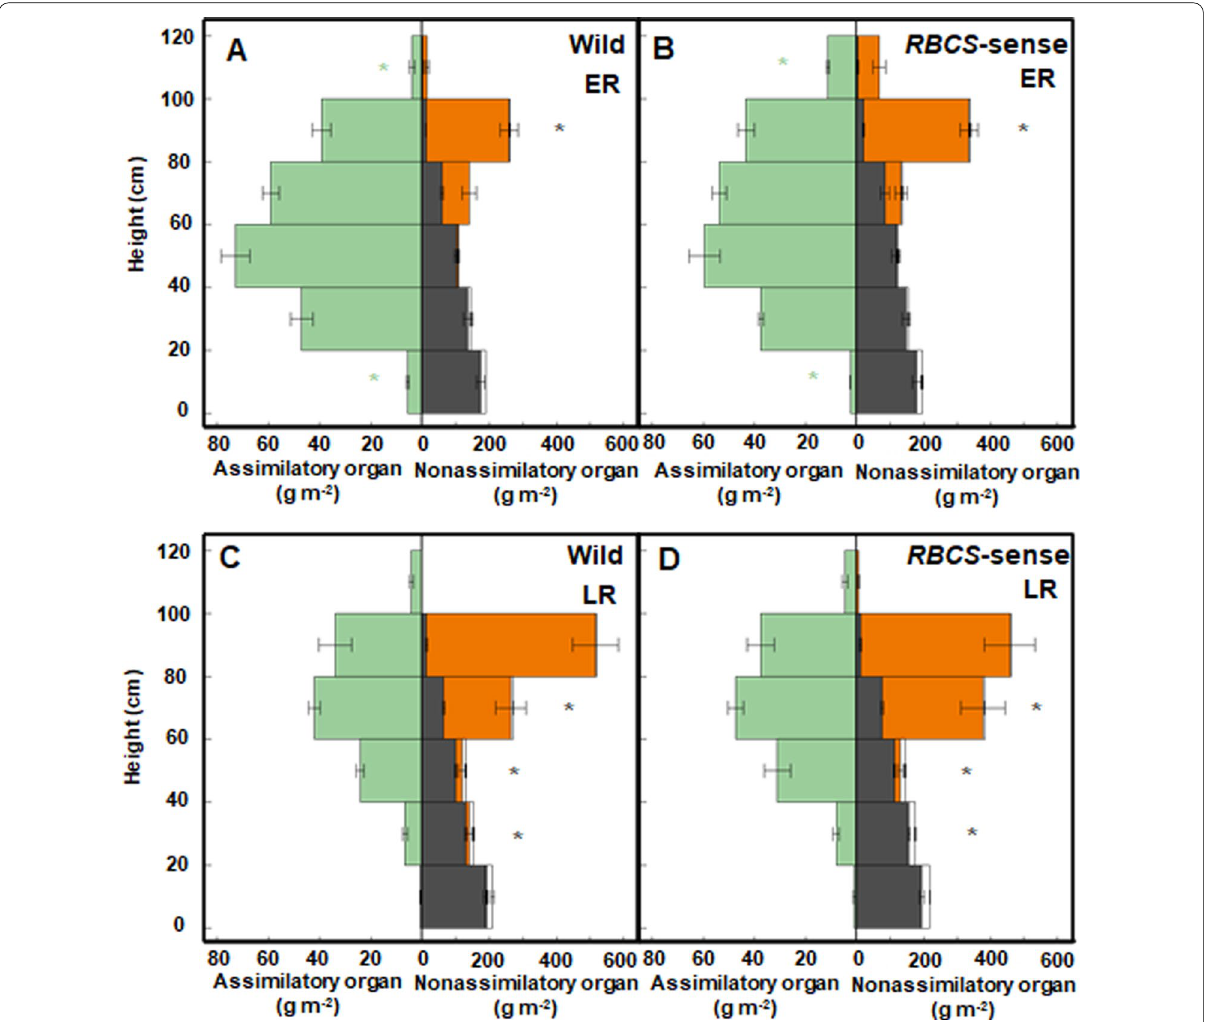
Fig. 3 Changes in the wild‑type ( A and C ) and RBCS ‑sense rice plants ( B and D ) canopy structures at 10 DAH in the early ripening stages and 49 DAH in the late ripening stages in the plots with 15 g N m − 2 fertilizer. Mean values the standard error of three independent plots are indicated. ± * p < 0.05 between the wild‑type and RBCS ‑sense rice plants using Student’s t- test. The dry weights of leaf blades, panicles, sheathes and stems, and dead organs are represented by green, orange, dark gray, and white bars, respectively. The abbreviations stand as follows: “DAH”; days after heading, “ER”; early ripening stage, “LR”; late ripening stage, “ RBCS ‑sense”; transgenic rice plants overproducing Rubisco, “Wild”; wild‑type rice